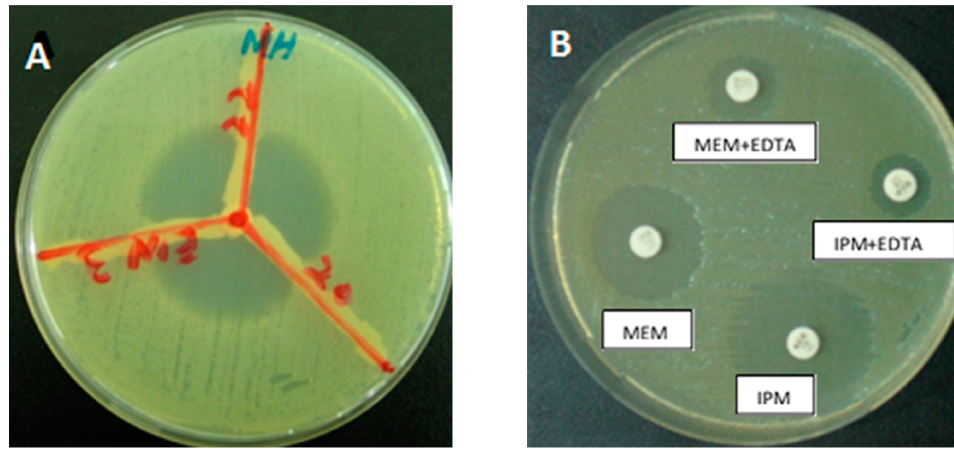
Figure 5. ( A ) Modified Hodge’s test for carbapenemase; ( B ) Double disc synergy method.